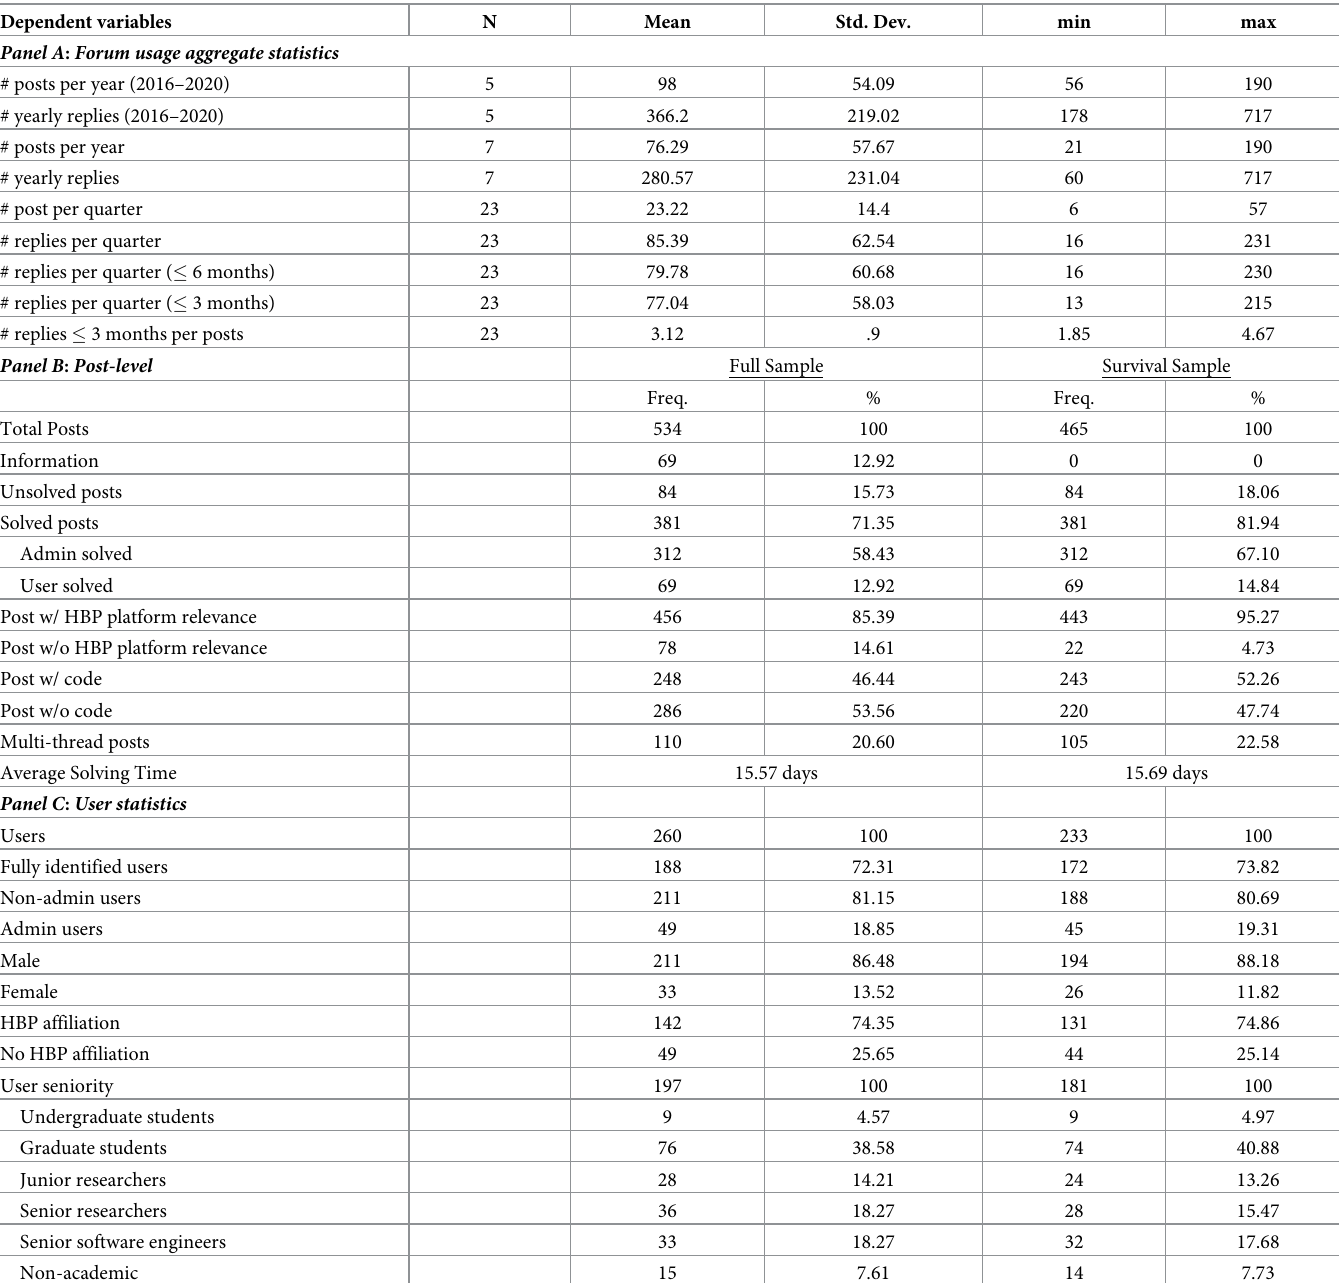
Table 1. Summary